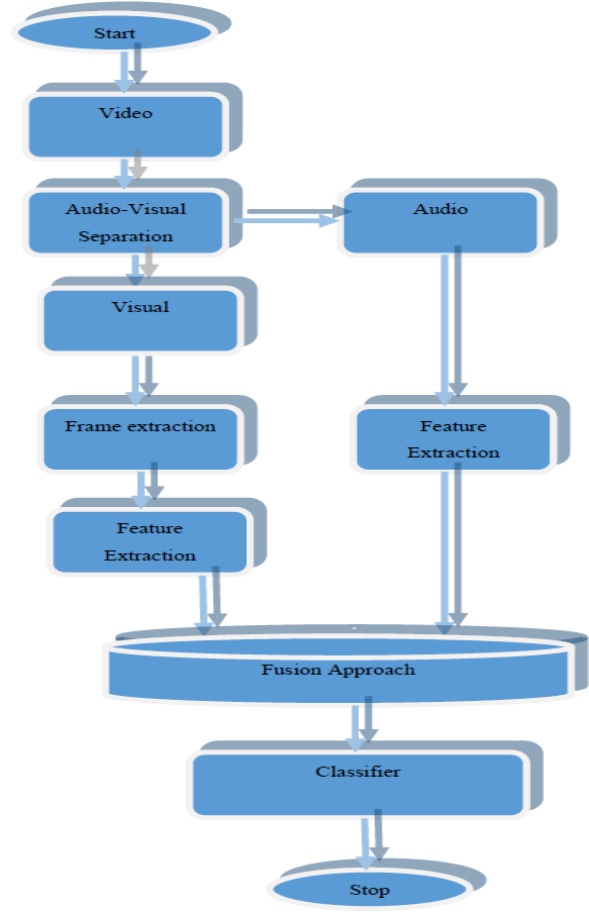
Figure 4. Workflow of the proposed system